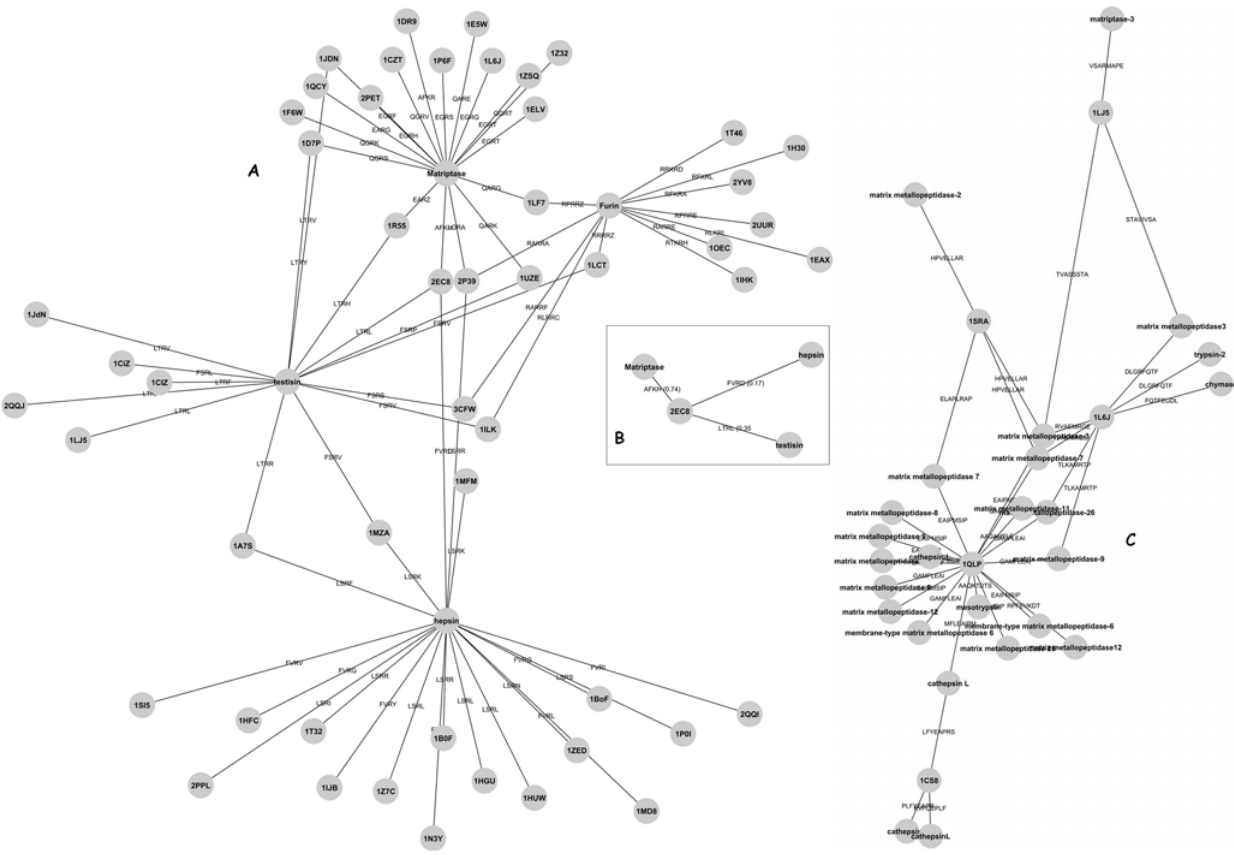
Figure 5. A proteolytic network based on rSASA values. A) Network was built using the program Cytoscape by linking substrates of furin, hepsin, matriptase and testisin derived from the PDB database. Inset B shows one substrate which is differentially accessible to the three enzymes. C) A network was similarly built using some of the proteases and their experimentally identified natural substrates.